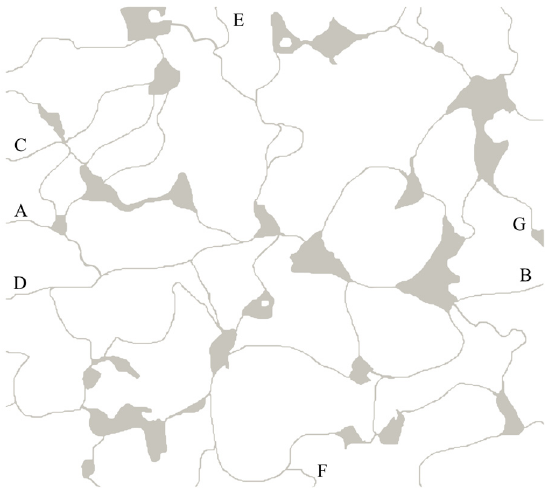
Figure 5. The pore structure of the core. A–G represent the inlet or outlet at different cases.